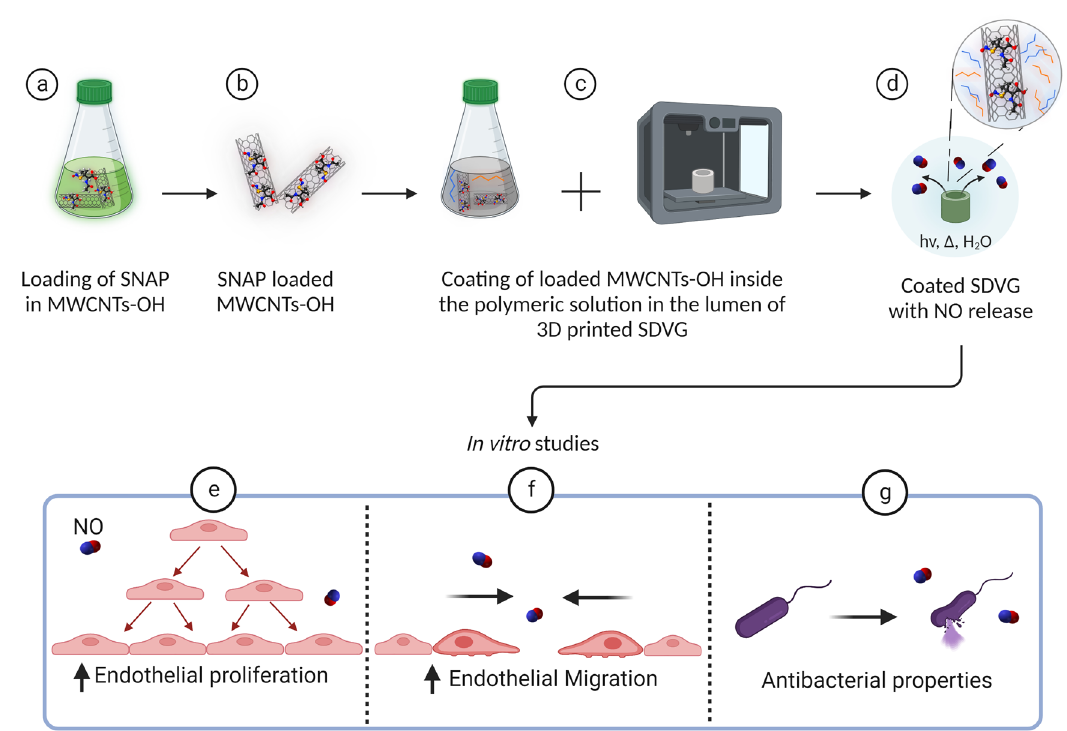
Figure 1. Schematic representation of the preparation of NO-releasing vascular grafts (SDVGs) and their biological properties in vitro. The upper panel shows ( a , b ) the loading of SNAP in MWCNTs-OH, ( c ) coating of them inside the lumen of 3D printed SDVG and ( d ) NO release from the coated SDVG. The lower panel indicates the biological properties of the NO releasing graft such as increase in EC proliferation ( e ) and migration ( f ) and antibacterial properties ( g